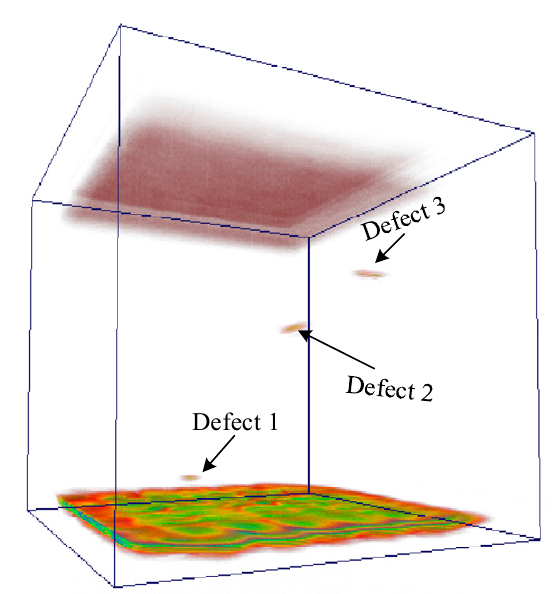
Figure 10. 3D imaging result based on the annular array TFM data.